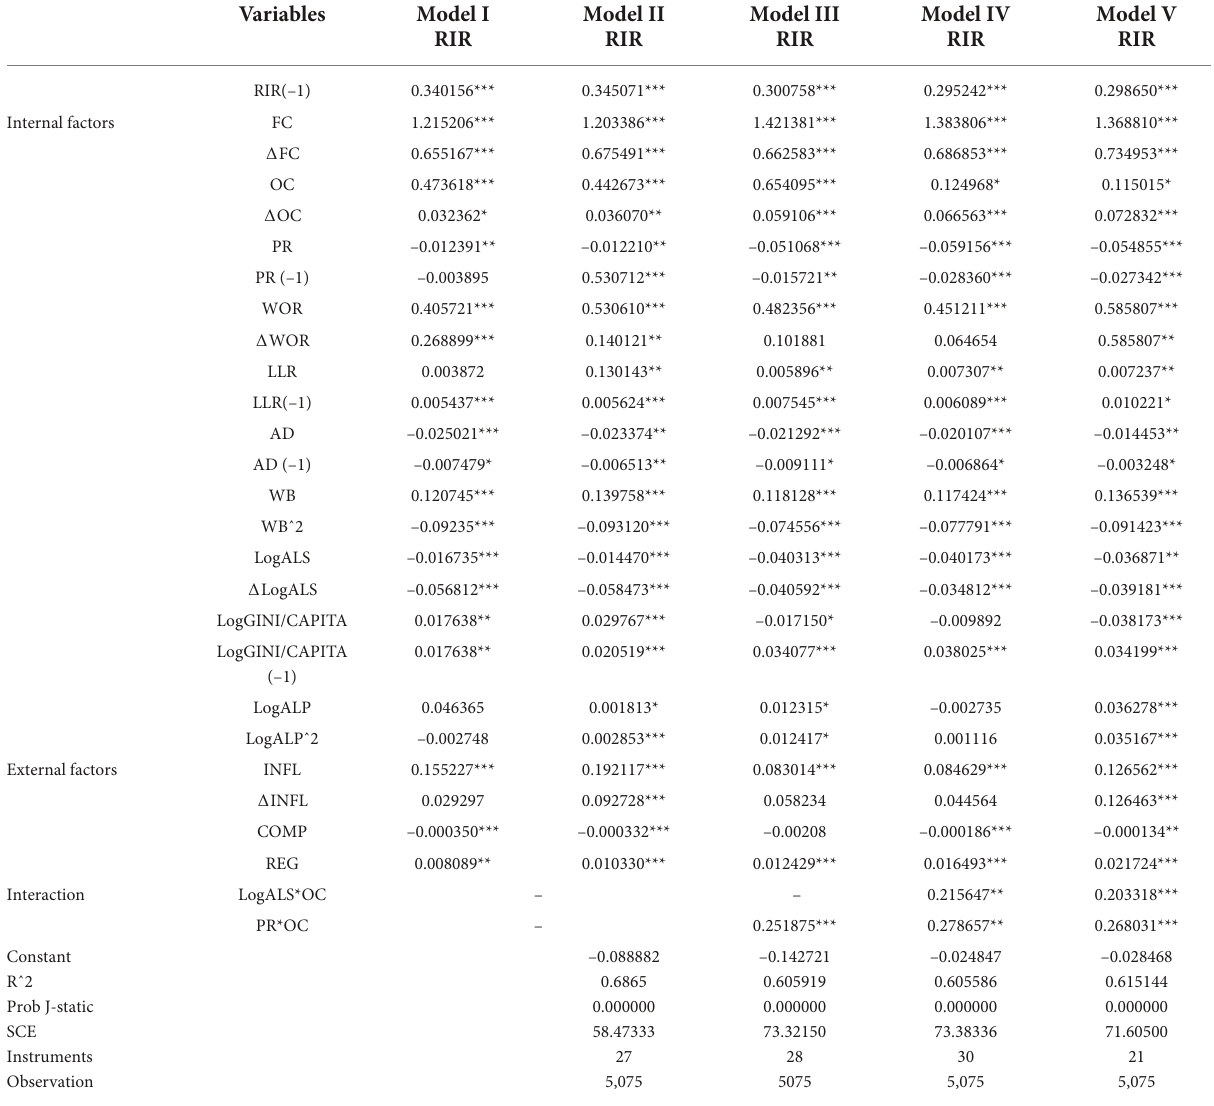
TABLE 9 Estimation results from